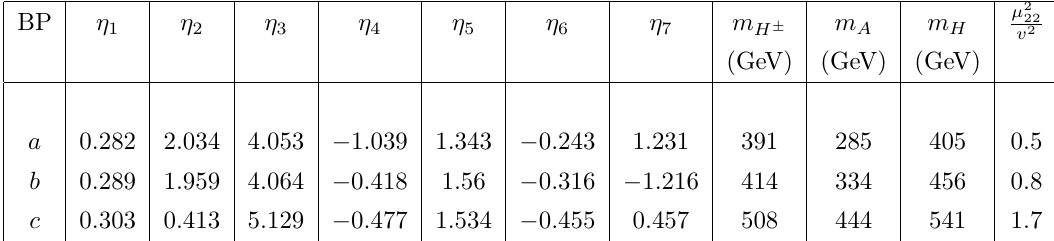
Table 1 . Parameter values of three benchmark points chosen from the scanned points in figure 1, which are consistent with the strong first-order EWPT.